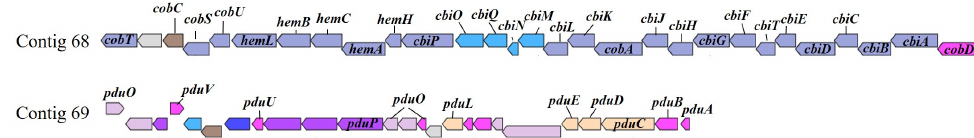
Figure 6. The schematic representation of the pdu-cbi-cbo-hem cluster of L. reuteri KGC1901. The genes encoding cobalamin synthetic genes were located in contig 68 ( upper ), and the genes encoding propanediol utilization genes were located in contig 69 ( lower ).